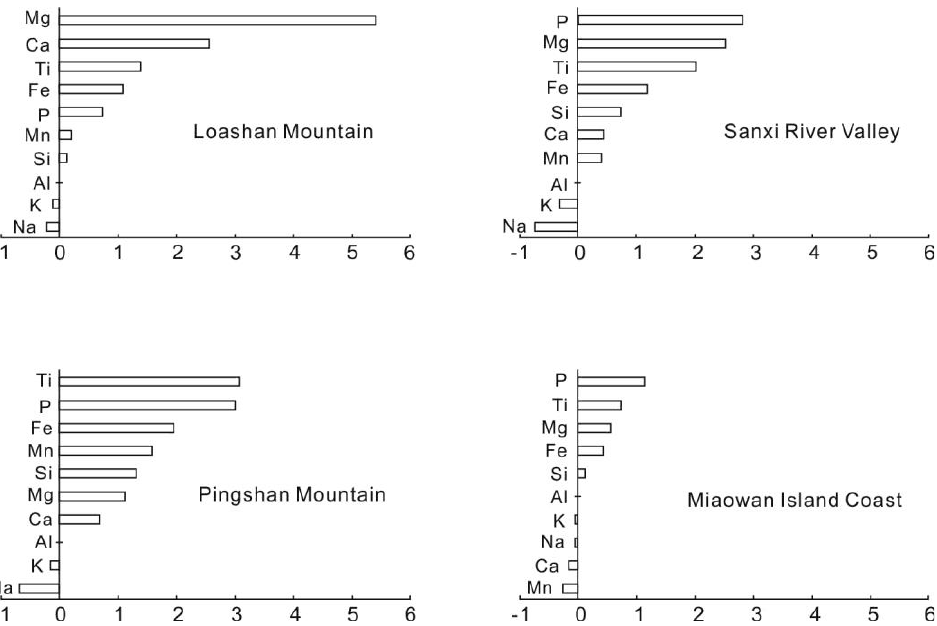
Figure 5. Mass balance due to major element migration in weathering pits in relation to the stable element Al.